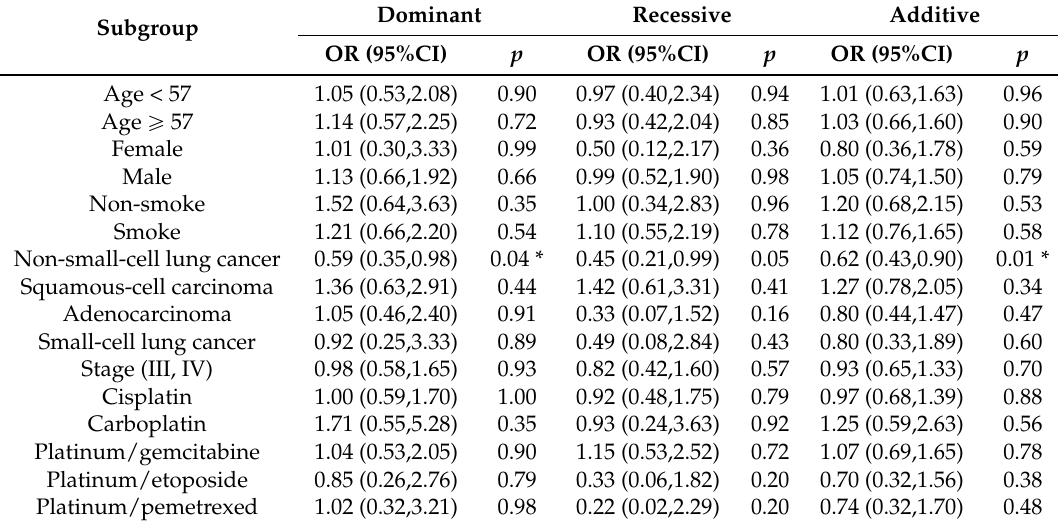
Table 10. Stratification analysis of relationship between CASC8 rs10505477 and hematologic toxicity induced by platinum-based chemotherapy in lung